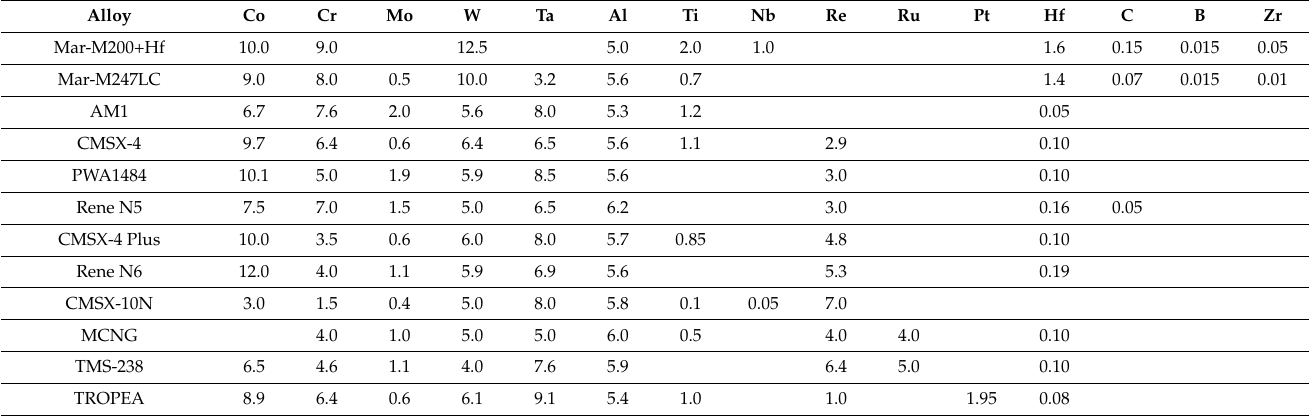
Table 1. Chemical compositions of experimental alloys in wt. %